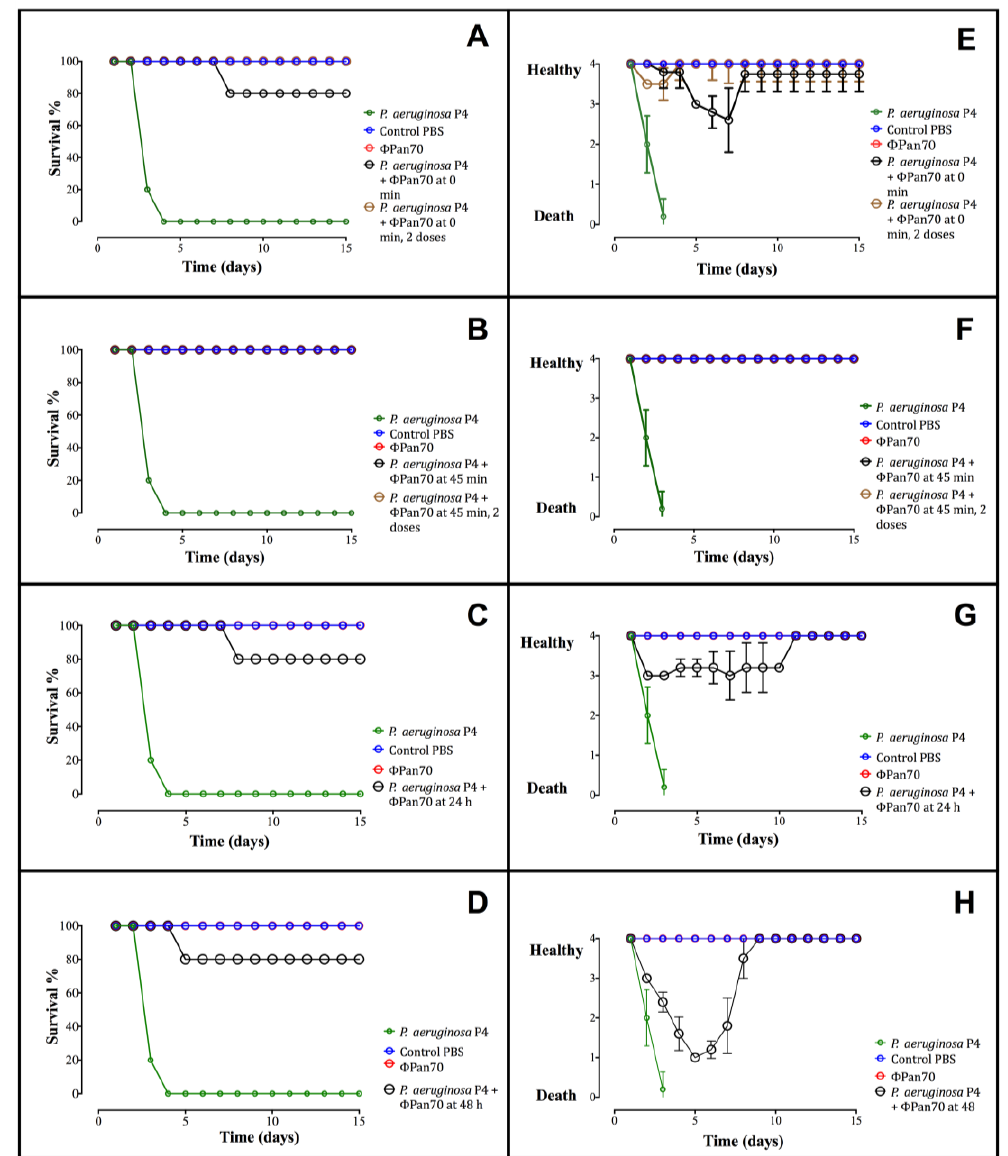
Figure 4. Survival percentage and health condition of mice treated with Φ Pan70. All the phage treatments showed a dramatic reduction in the mortality of the mice and a general health condition improvement. Survival percentage was calculated according to the number of surviving animal recorded at each day of the experiment (Tables S3 and S4). The health condition was rated on a scale of 4 to 0; 4: Healthy; 3: Small discharges from the eyes; 2: Discharge from the eyes, goose bumps and little activity; 1: Significant weight loss and no activity at all; and 0: Dead animal. In an additional experiment, groups of mice treated at 0 min and 45 min received a second phage dose 48 h after the initial one. ( A , E ): Survival percentage and health condition, respectively, of the mice treated with Φ Pan70 at the same time as bacterial inoculation (0 min). ( B , F ): Survival percentage and health condition, respectively, of the mice treated with Φ Pan70 45 min after bacterial inoculation. ( C , G ): Survival percentage and health condition, respectively, of the mice treated with Φ Pan70 24 h after bacterial inoculation. ( D , H ): Survival percentage and health condition, respectively, of the mice treated with Φ Pan70 48 h after bacterial inoculation.